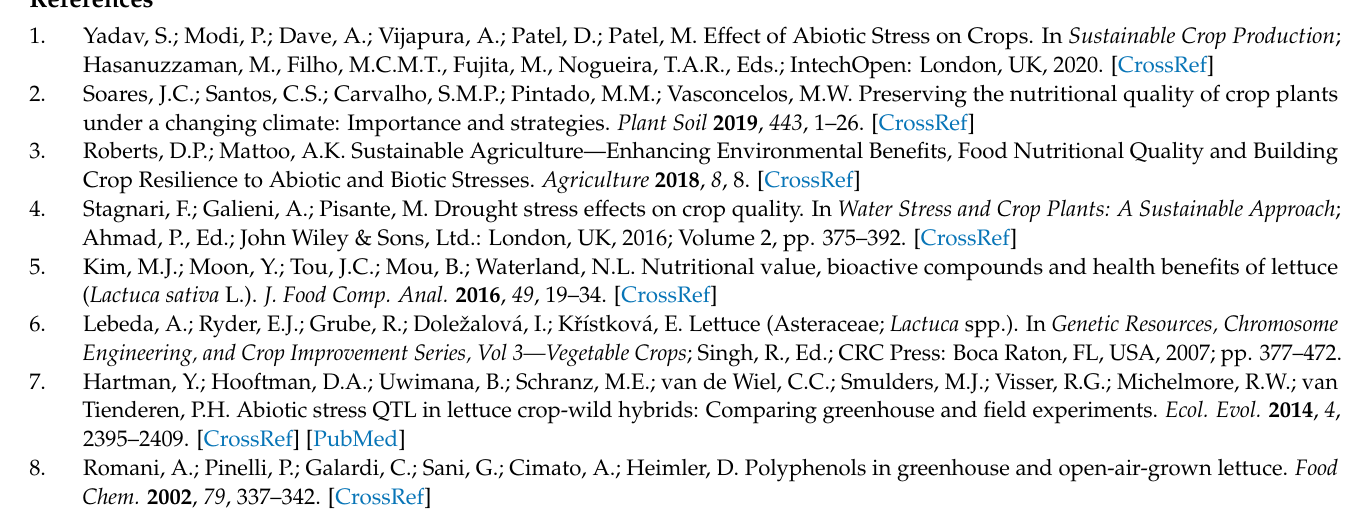
number: CZ.02.1.01/0.0/0.0/16_019/0000827) within the program Research, Development